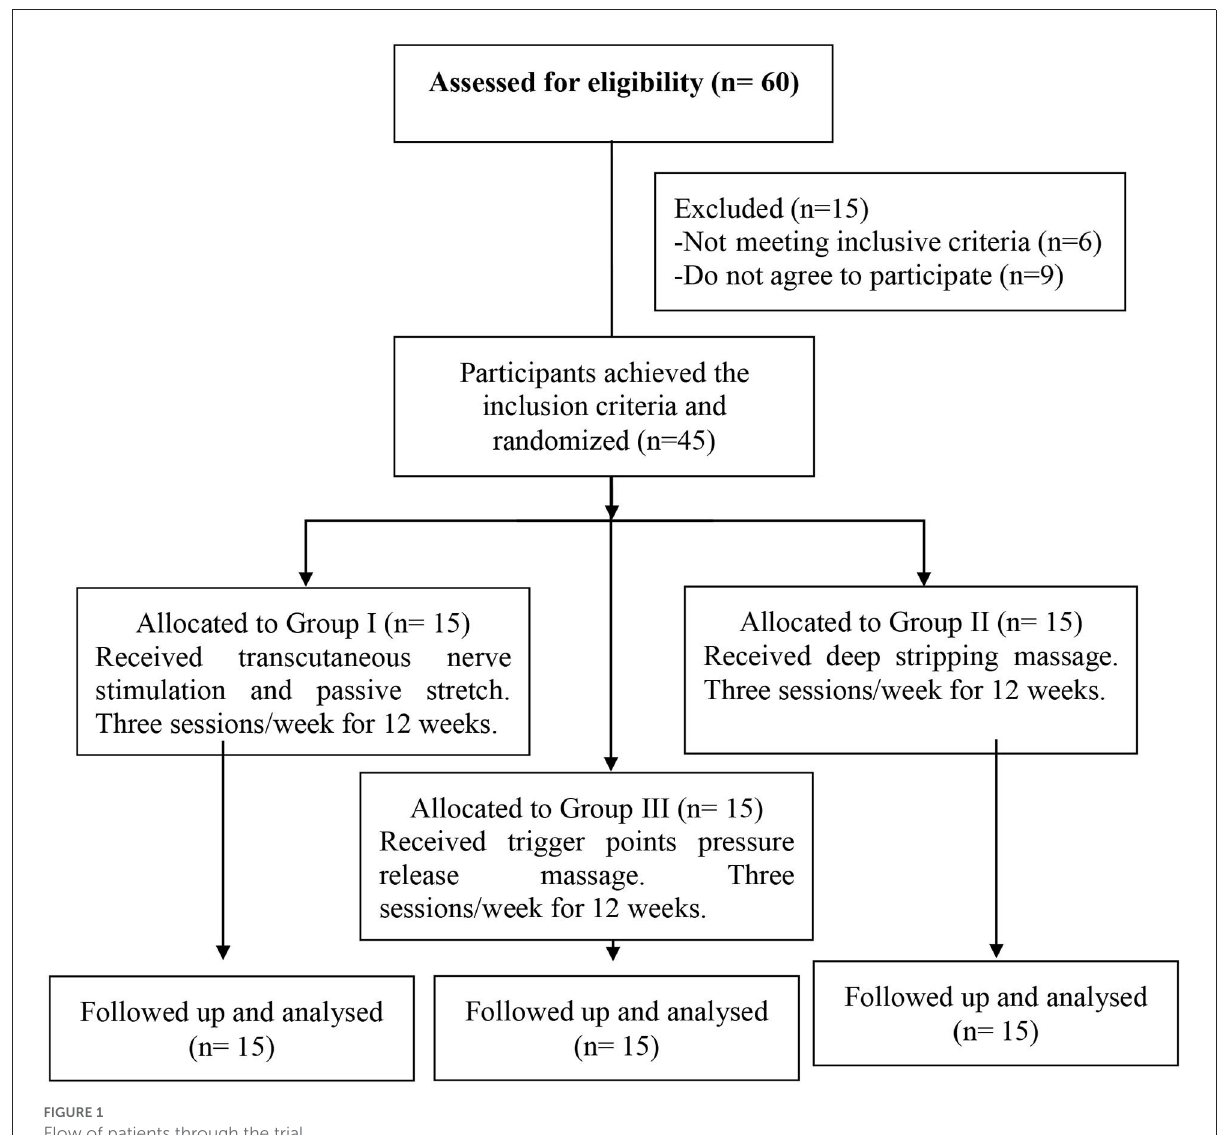
FIGURE1 Flow of patients through the